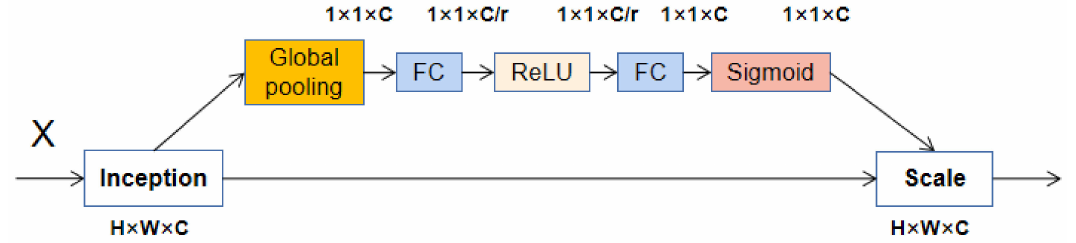
Figure 4. SE block